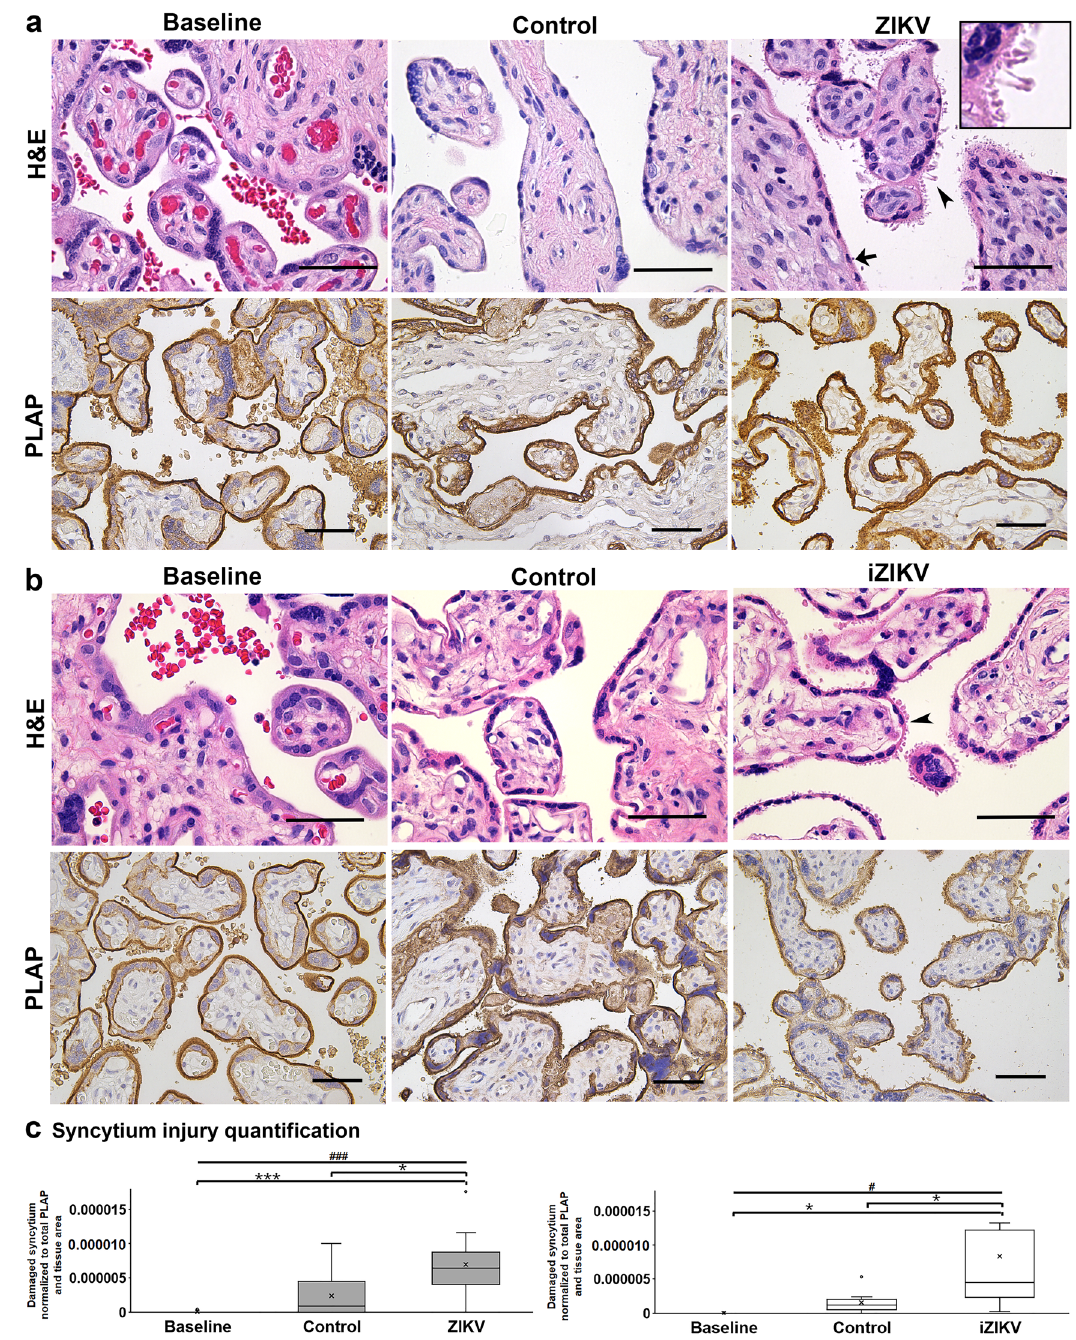
Fig. 5 ZIKV and iZIKV invoke syncytium injury. H&E and PLAP staining representing syncytium remodeling (arrowheads) at Baseline and following exposure to ZIKV ( a ) and iZIKV ( b ). In the ZIKV panel, an arrow denotes normal syncytium and the inset (right corner) magni fi es the damaged region designated by the arrowhead. PLAP staining is represented by DAB in brown. Scale bars = 50 µ m. c Quanti fi cation of syncytium remodeling in PLAP stained sections normalized to the total area of tissue within each image analyzed. The left graph represents n = 10 and right graph n = 9 samples per condition. Box-plots represent the median in the center line, upper and lower quartiles at top and bottom of box, min/max points as whiskers, outliers as dot, and the mean with x. # p < 0.005, ### p < 0.0005 by one-way ANOVA. * p < 0.05, *** p < 0.0005 by Tukey ’ s post-hoc